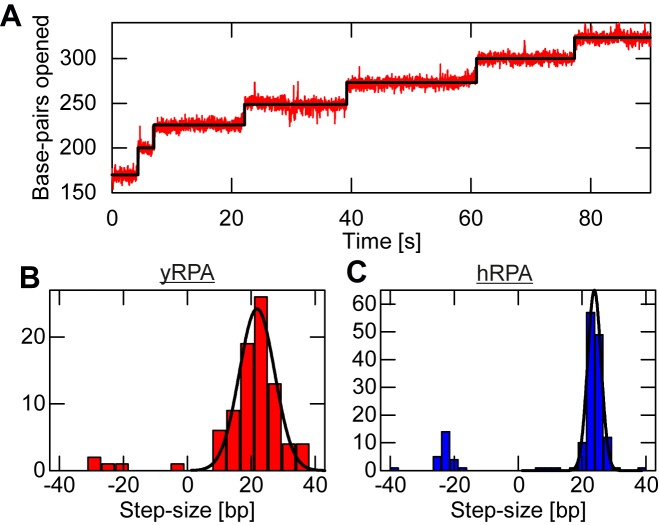
Binding site size of RPA. (A) Exemplary time trace yRPA association (2 nM yRPA, 10 mM Mg2+) on the hairpin substrate showing clearly resolved steps at a force of 12.0 pN. (B) Step size distribution for yRPA (from multiple traces collected under the same conditions), calculated using a step finding algorithm. The step size of 21.8 bp occurs most frequently in the data). (C) The step size distribution for hRPA association data (collected at (5 nM hRPA, 10 mM Mg2+, 12.0 pN) is similar, with the most common size being 23.8 bp.